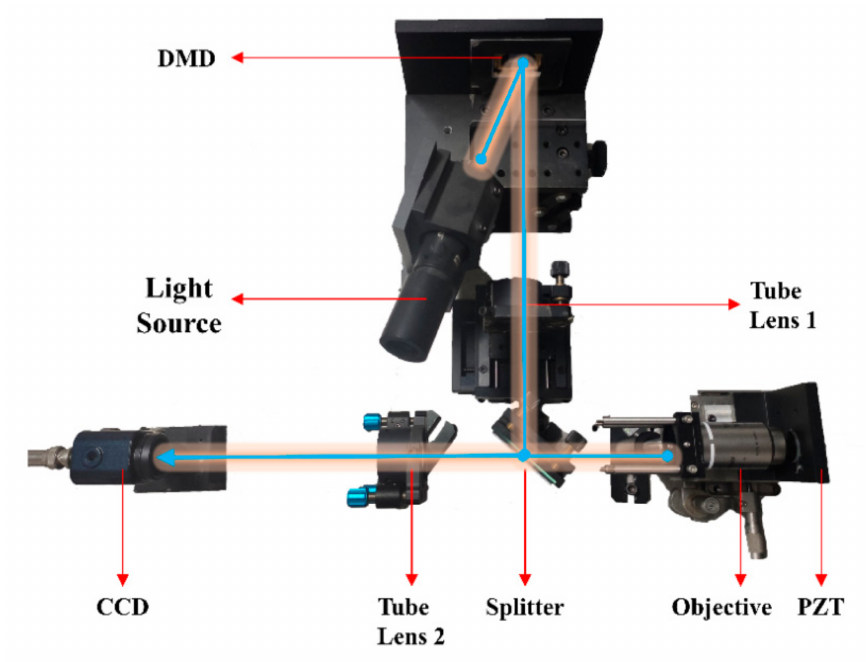
Figure 7. The schematic of the measurement system.